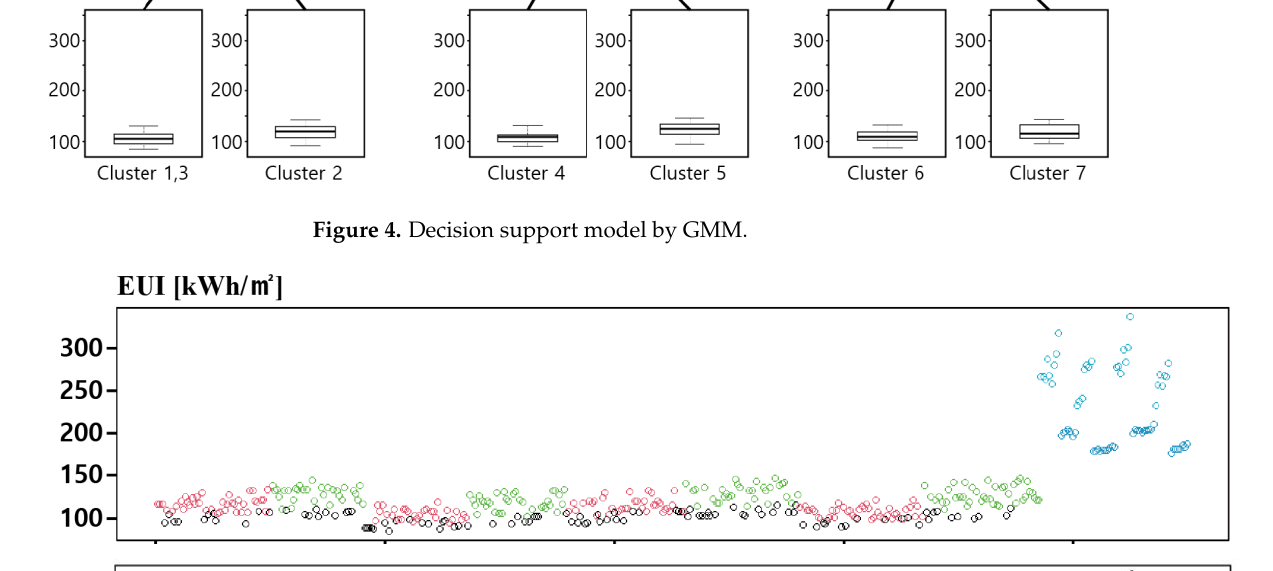
Figure 4. Decision support model by GMM.